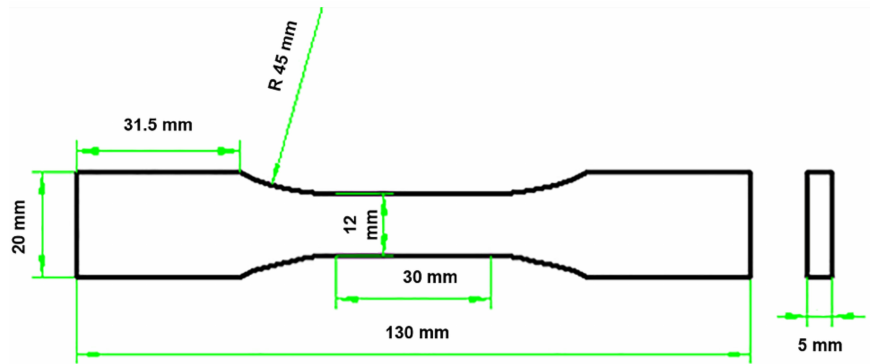
Figure 4. Specimen configuration for monotonic and loading/unloading cyclic